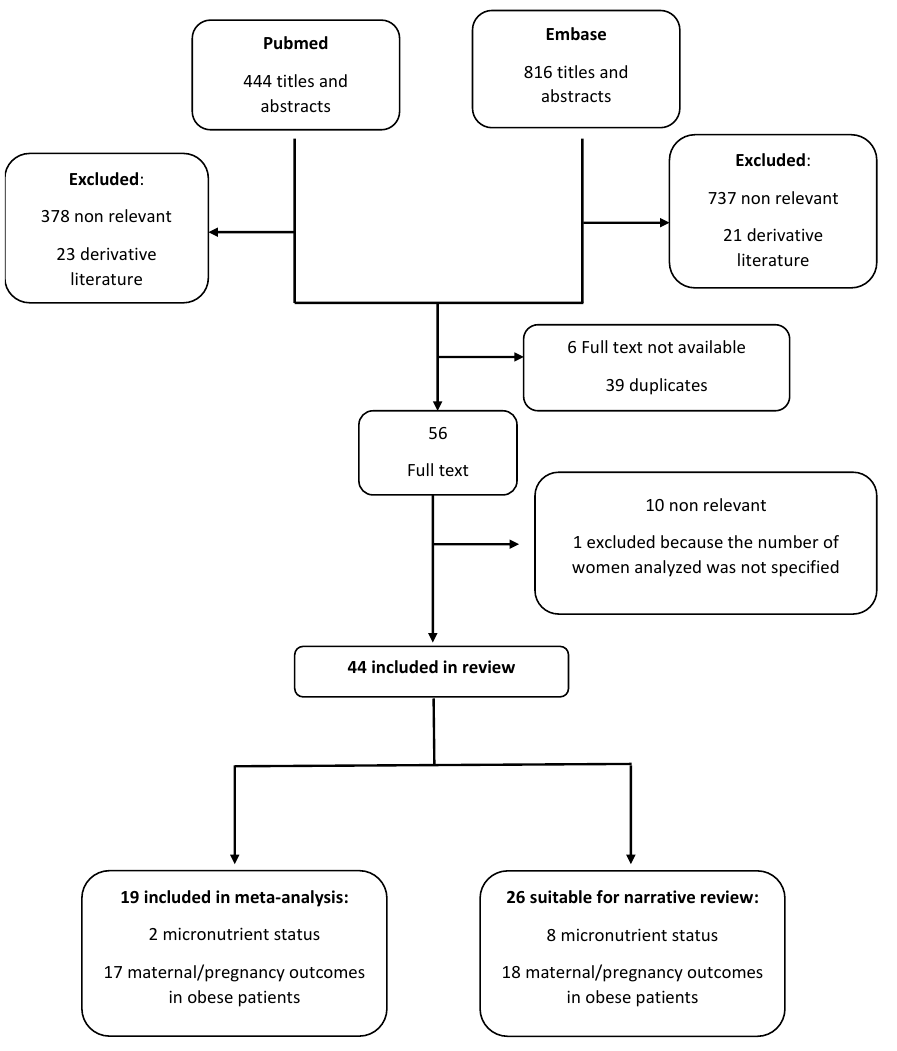
Figure 1. Flow chart for the selection of studies.